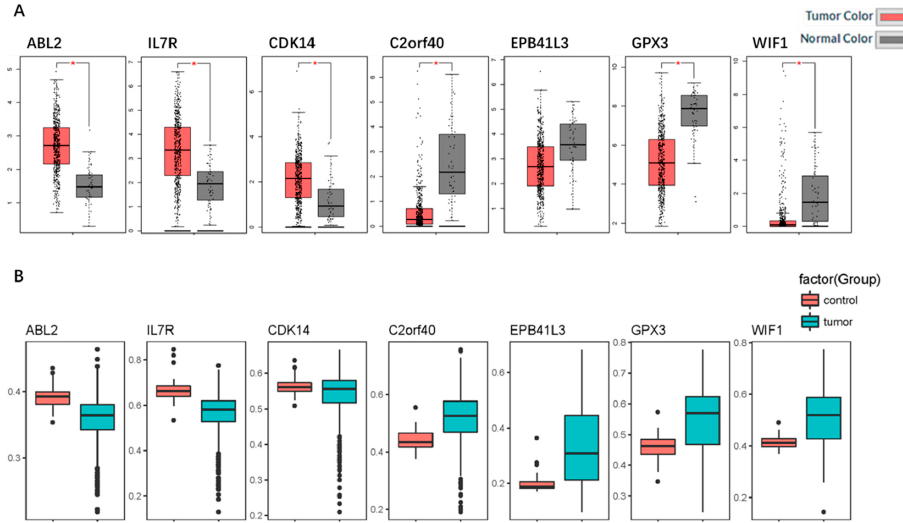
Figure 5. Validation of the seven genes in the Cancer Genome Atlas (TCGA) database. ( A ) Box plots showing the expression of the seven genes in messenger RNA (mRNA) expression, using data from the TCGA database in GEPIA. The statuses of the expression of six genes were the same as in our study, and their p -values < 0.05 ( EPB41L3 was not statistically significant). ( B ) Box plots showing the methylation status of the seven genes using the data from the TCGA database. The methylation statuses were in accordance with our